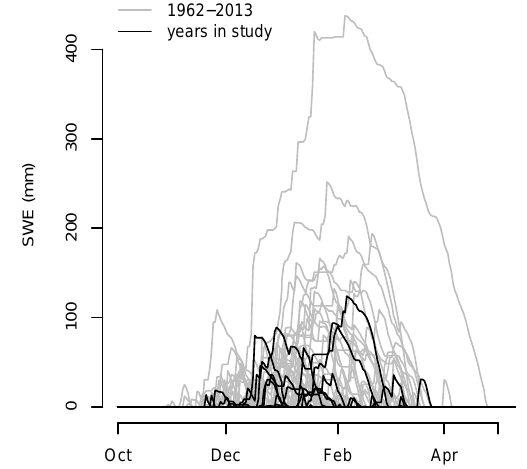
Fig. 9. Comparison of modelled historic snow water equivalent for winters of 1962 to 2013. Black lines represent years used in the historic East Creek study and grey lines represent years for which stream temperature data are not